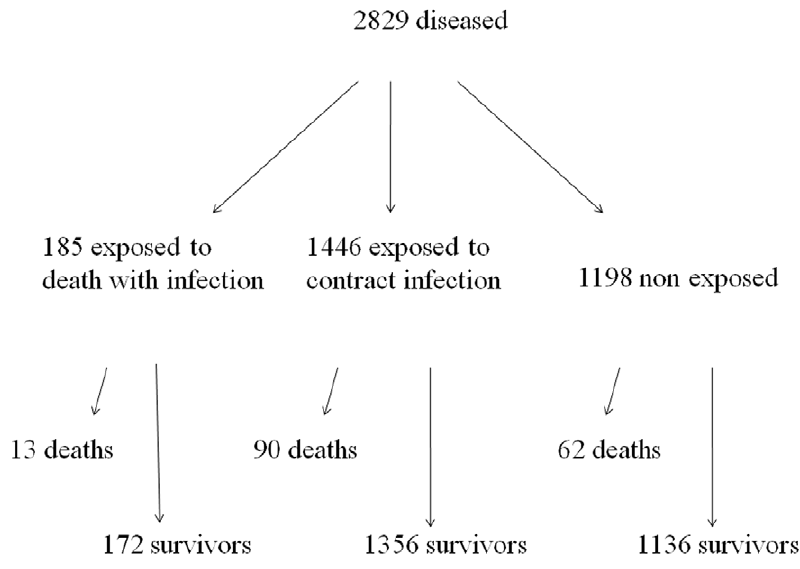
Figure 3. The 2829 (1631 + 1198) diseased siblings in the analyses of case-fatality.